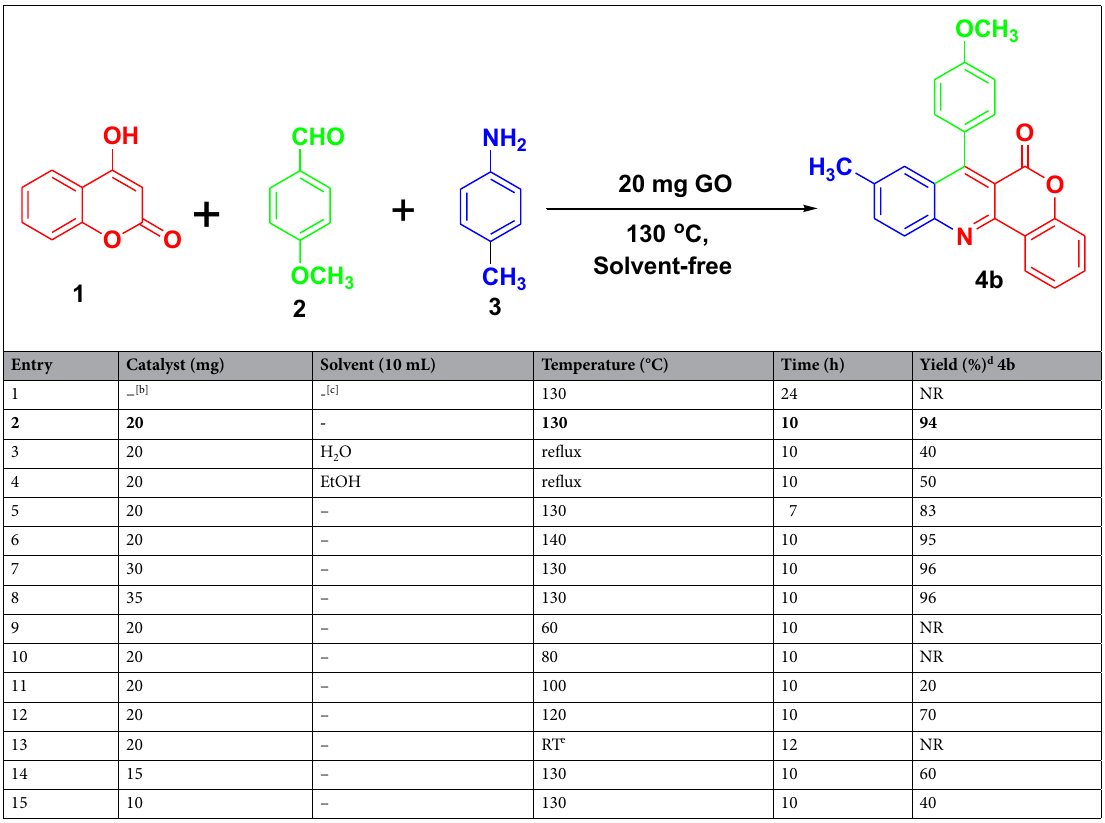
Table 1. Optimization of reaction parameters for the synthesis of Chromeno-[4,3- b ]-quinolin-6-ones in the protocol a . [a] Reaction conditions: 4-hydroxycoumarine (1, 1 mmol), 4-methoxy benzaldehyde (2, 1 mmol), p -toludine (3, 1 mmol), GO (20 mg) at different temperatures, [b] In absence of catalyst, [c] Under solvent-free condition. [d] Isolated yields, [e] room temperature reaction, NR = no yield of the desired